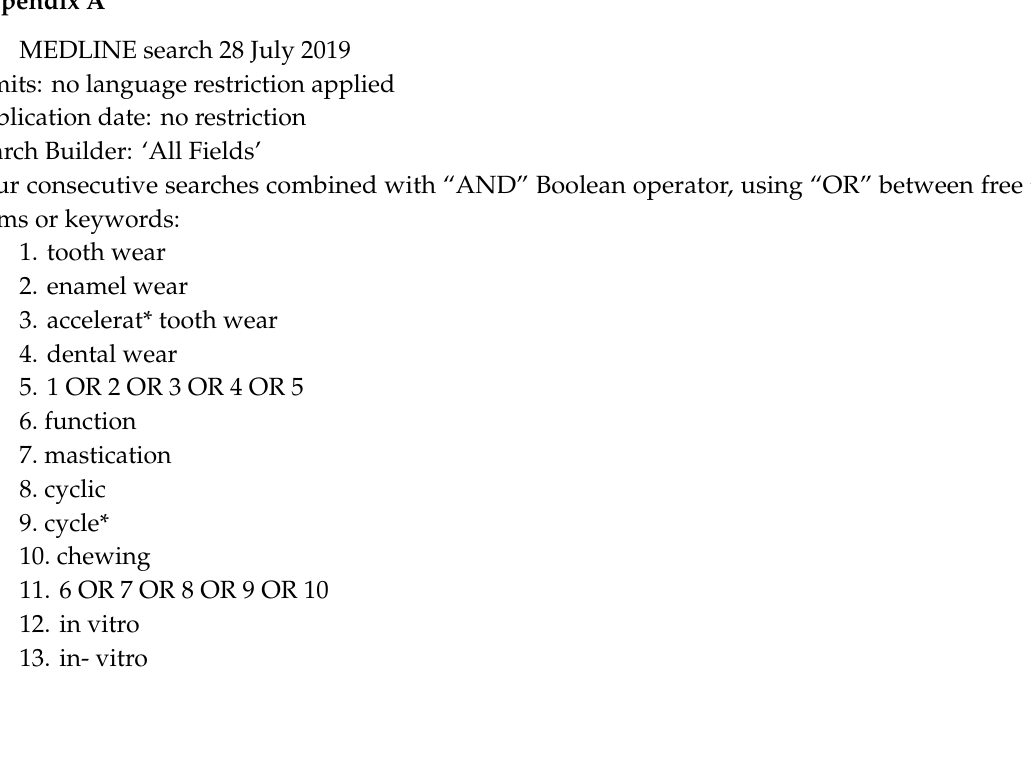
Table S1: Characteristics of included studies in alphabetical order (n = 27). Table S2: Detailed assessment of included randomized trials with the RoB 2.0 tool (supplement to Table 1). Table S3: Detailed assessment of included non-randomized studies with the ROBINS-I tool (supplement to Table